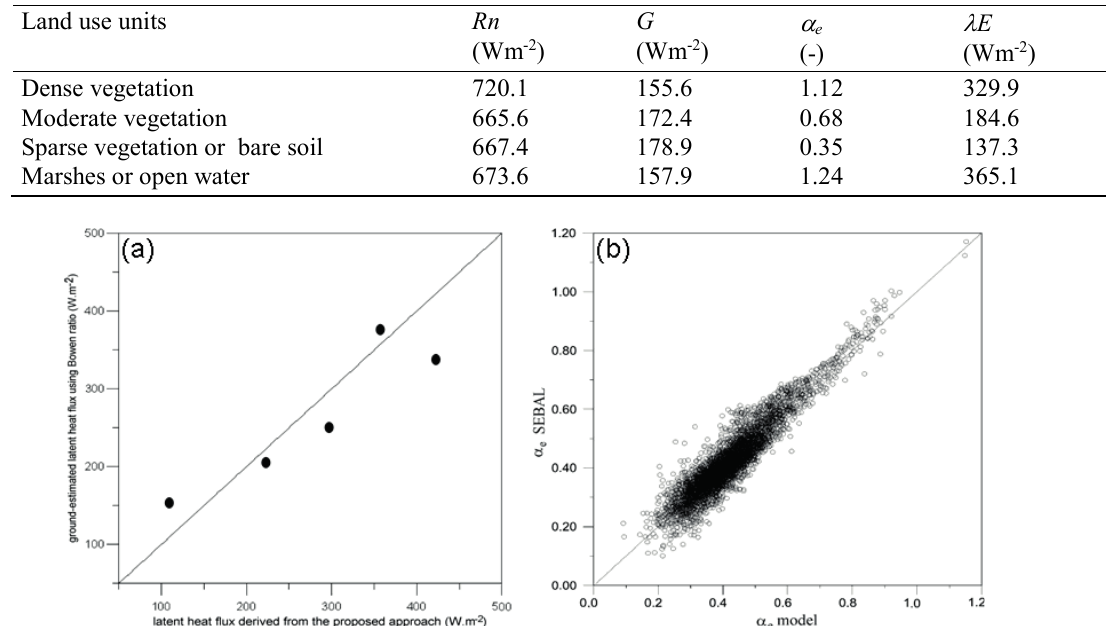
Table 1 Variation of surface energy fluxes and the alpha parameter with land use in the study area.